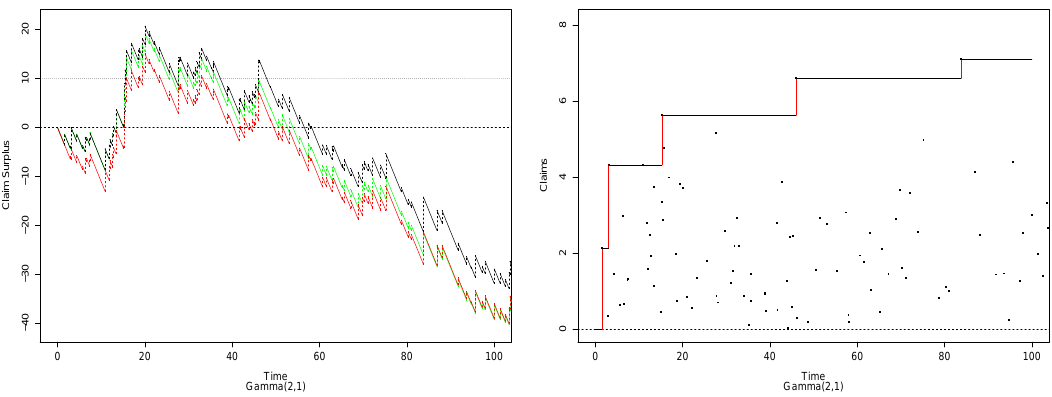
Figure 3. Sample paths of the insurance risk processes without reinsurance (black line), with LCR reinsurance (red line), and with excess of loss (EOL) reinsurance (green line), for a Gamma ( 2,1 ) claim distribution. The safety loading is θ = 0.1, expected claim size is µ = 2, claim arrival rate is λ = 1, and each time unit is 0.01 years. L for the EOL scheme is chosen so that the expected values of the LCR and EOL claim distributions are equal at maturity time T =